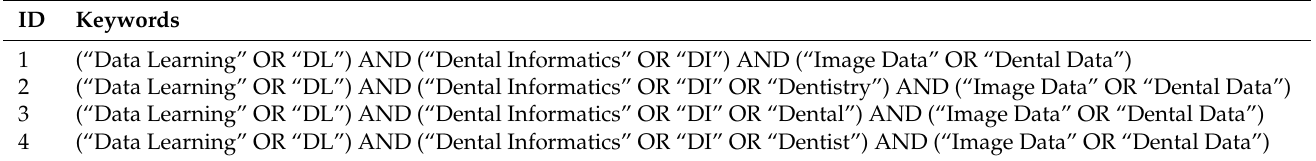
Table 1. Inclusion and exclusion criteria description of research